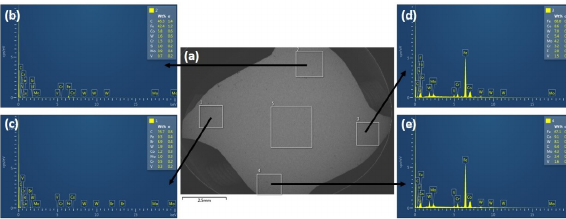
Figure 4: EDS analysis at the surface adjacent to fracture surface (a) points EDS, (b) EDS spectra of point 2, (c) EDS spectra of point 1, (d) EDS spectra of point 3, (e) EDS spectra of point 4